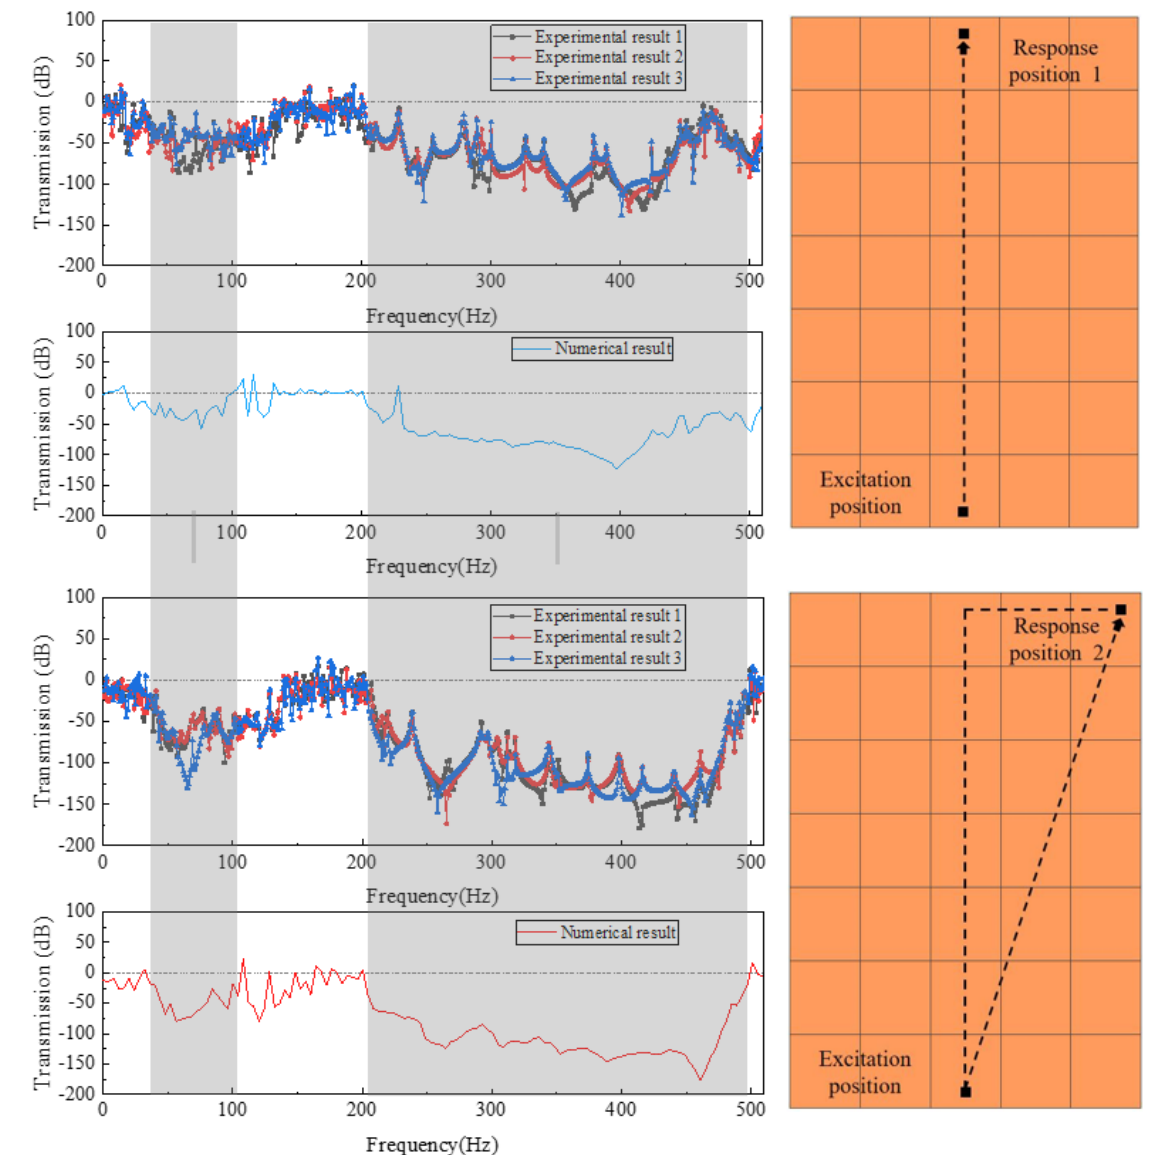
Figure 11. Experimental validation of flexural vibration frequency responses.